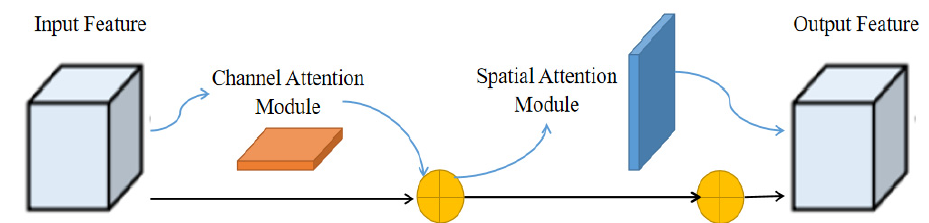
Figure 5. CBAM architecture is shown in the figure, which is composed of two serial modules: chan- nel attention and spatial attention.